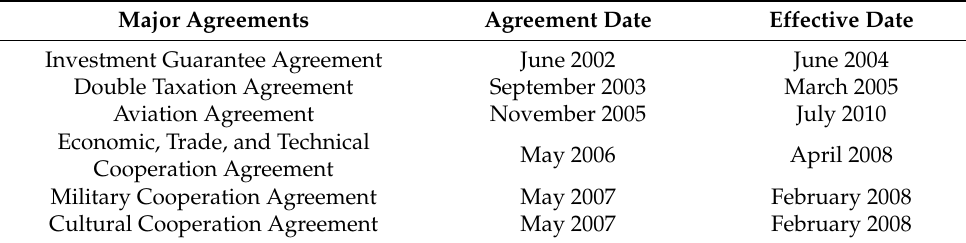
Table 2. Major agreements between South Korea and the